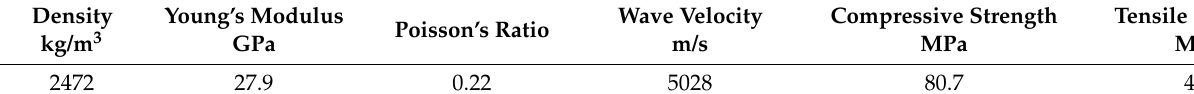
Table 1. Quasi-static properties of the green sandstone.